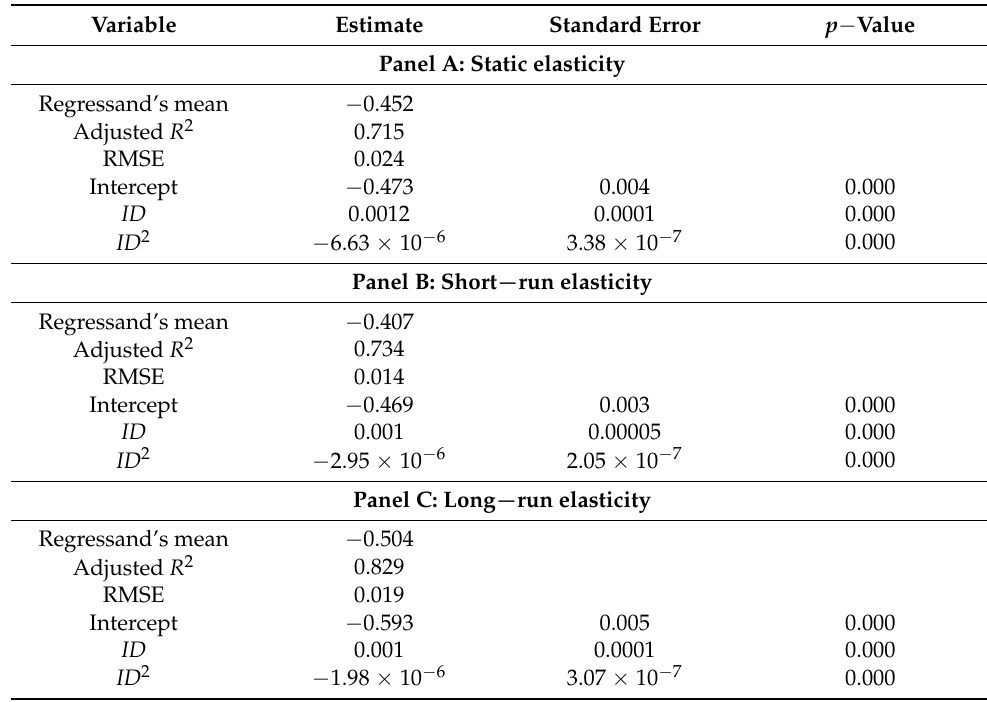
Table 6. OLS time trend regression: Own-price elasticity estimate = intercept + b 1 ID + b 2 ID 2 + error; sample size = 241 observations for each elasticity type.